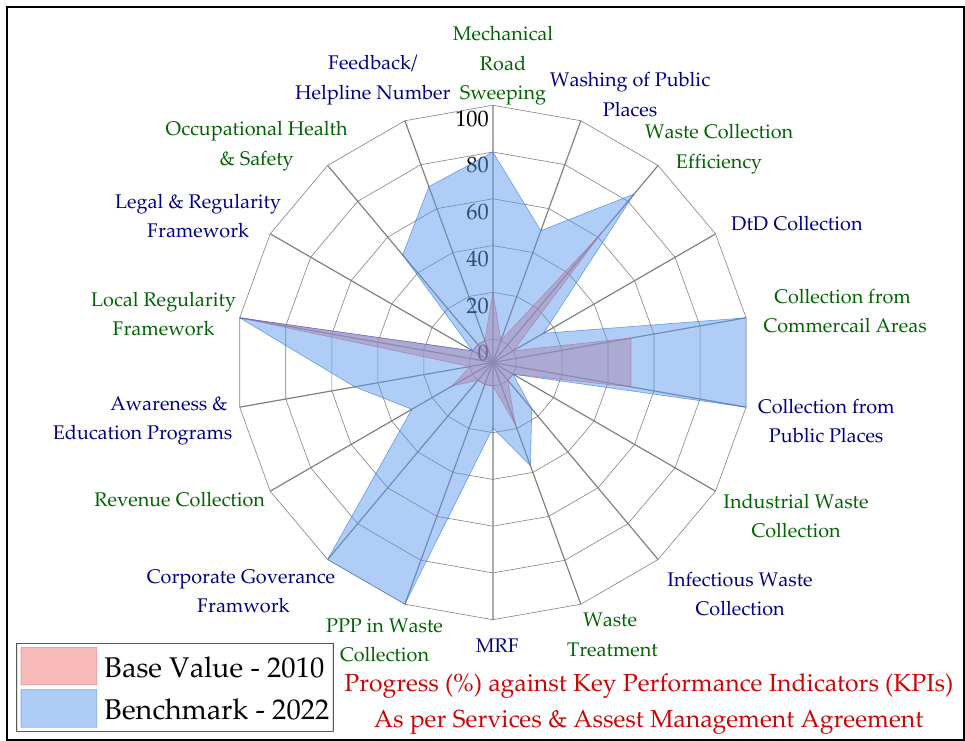
Figure 20. Progress of LWMC against agreed KPIs as per legal agreement with City District Government/Municipal Corporation Lahore.